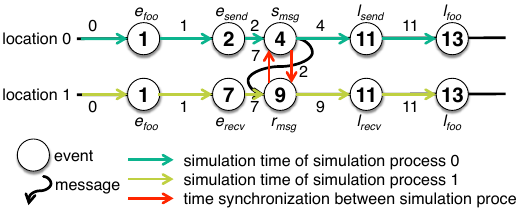
Figure 6: Time synchronization between simulation processes. Function enter or leave events are